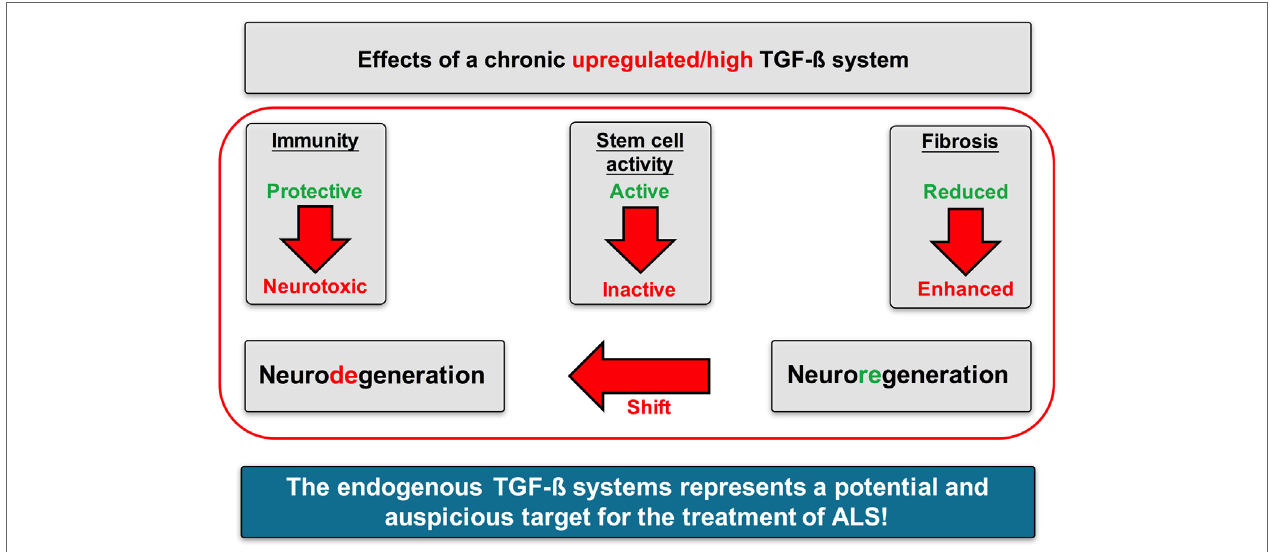
FigUre 13 | Proposed mechanisms of action of TGF­ β signaling in Amyotrophic lateral sclerosis (ALS). A chronically upregulated TGF­ β system activity promoted the imbalance of neurodegenerative and neuroregenerative processes favoring neuronal loss by (i) shifting the immune response toward a proinflammatory neurotoxic and neurodestructive milieu, (ii) shifting the activation state of neuronal stem cells toward an arrested/inhibited phenotype, and (iii) promoting fibrotic activity at the side of neuroinflammation and neuronal